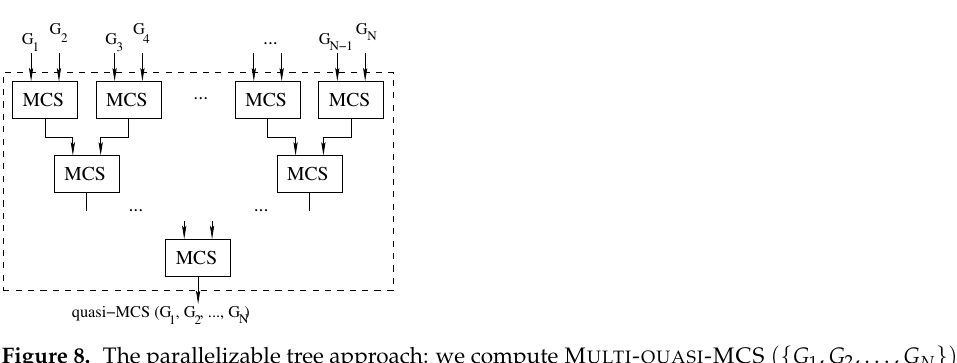
Figure 8. The parallelizable tree approach: we compute M ULTI - QUASI -MCS ( { G 1 , G 2 , . . . , G N } ) as MCS ( . . . MCS ( MCS ( G 1 , G 2 ) , MCS ( G 3 , G 4 )) , . . . ) .